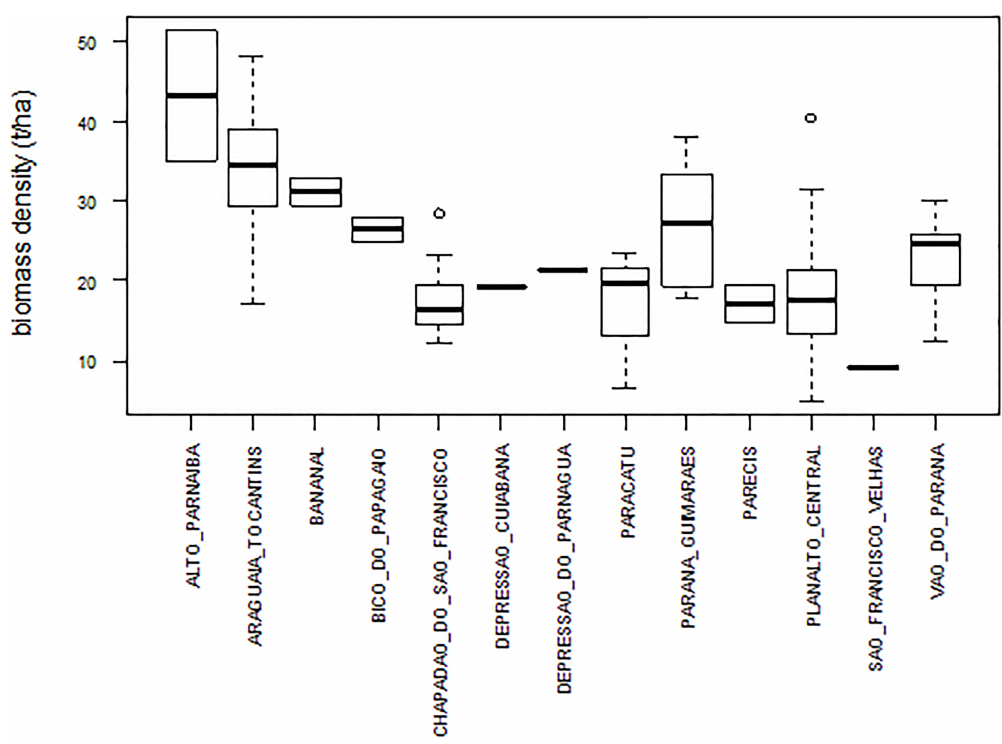
Fig 3. Tree aboveground biomass density of cerrado sensustricto in 13 cerrado ecoregions, estimated with model 11.